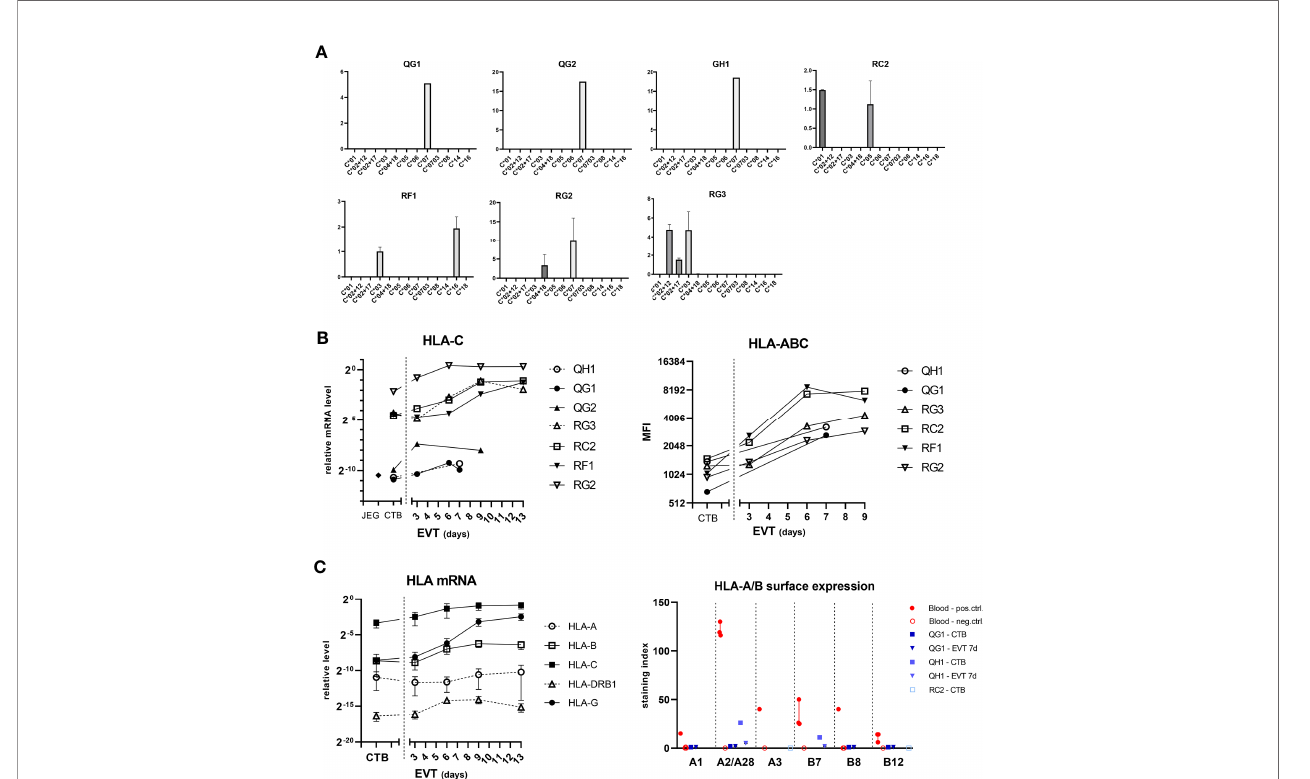
FIGURE 5 | Expression of HLA-C in trophoblasts. (A) Messenger RNA expression of HLA-C according to the HLA-C alleles. RNA from CTB cultures (n = 7) was analyzed by quantitative PCR using primer sets that are speci fi c for different HLA-C alleles. The vertical axes represent relative mRNA expression of HLA-C alleles, corrected for the average signal of two reference genes ( GAPDH , ACTB ). The graph shows means with SEM of two independent experiments per culture. (B) HLA-C mRNA expression was determined by quantitative PCR using generic primers that targeted all alleles (left panel). HLA-C was also studied by fl ow cytometry using antibodies against pan-HLA class I (right panel). (C) Messenger RNA expression of HLA-A , -B , -C , -DRB1 , and -G (left panel) was studied in CTB and EVT cultures. RNA was analyzed by quantitative PCR using locus-speci fi c primer sets. The graph shows means with SEM. Surface expression of individual HLA-A and HLA-B alleles was investigated by fl ow cytometry using human monoclonal antibodies on four blood cell samples and two trophoblast cultures (right panel). The graph displays medians with interquartile